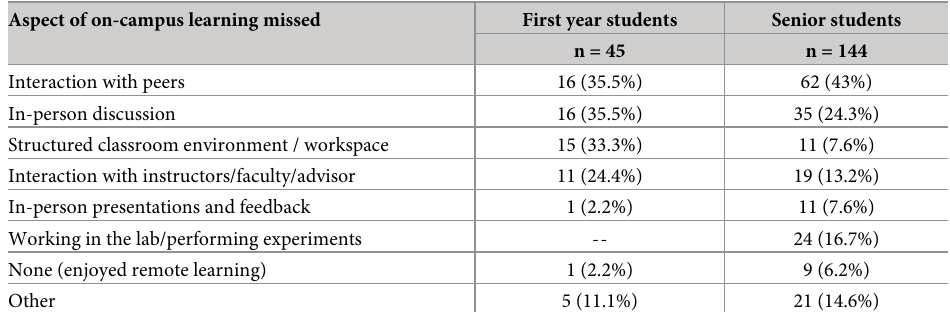
Table 3. Aspects of on-campus learning missed by